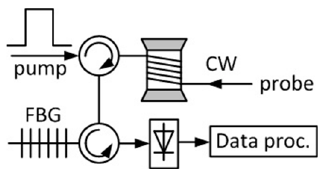
Figure 5. Simple scheme of a Brillouin optical time domain analyser. The pump and probe are counter-propagating in the fibre; the probe light is detected and processed to retrieve the local Brillouin frequency.